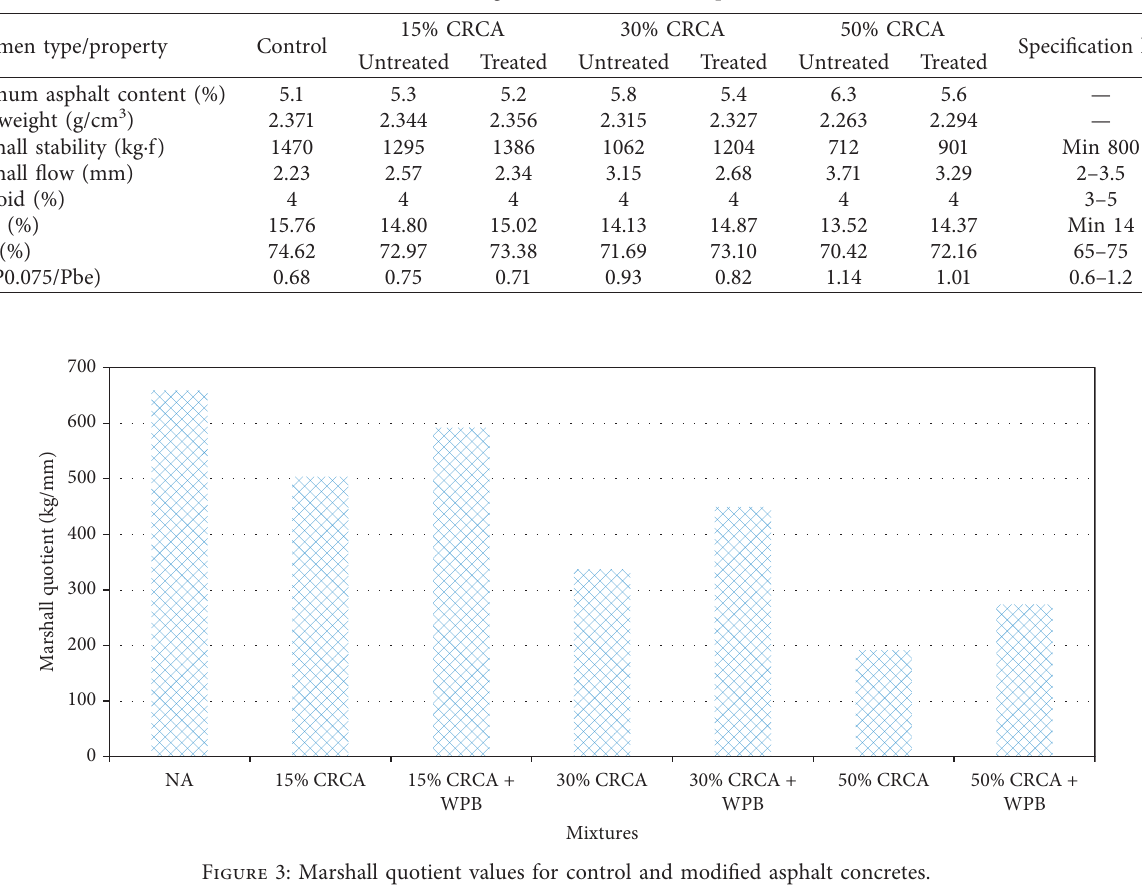
Table 4: Mix design results for different